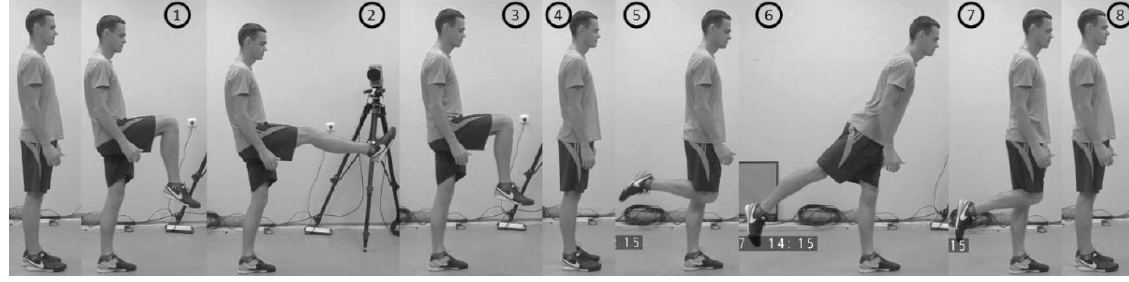
Figure 1. Motion test for the legs.